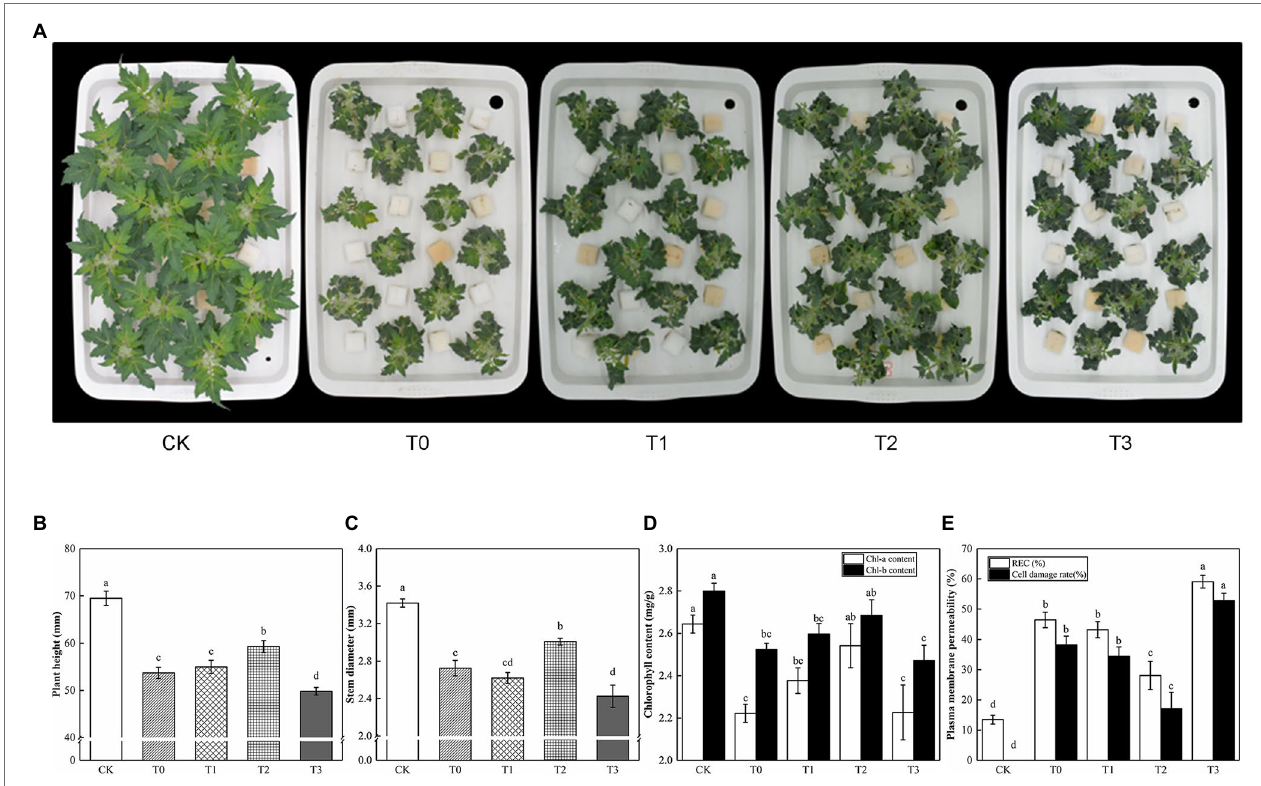
FIGURE 2 | Effect of different concentrations of trehalose on the growth and physiological parameter of tomato seedlings. Photographs and data were obtained after 5 days of treatment. (A) Morphological changes. (B) Plant height. (C) Stem diameter. (D) Chlorophyll content. (E) Plasma membrane permeability. The results showed the mean ± SE of three replicates, and the different letters denote the significant difference among treatments ( p < 0.05), according to Duncan’s multiple test. CK, control; T0, 150 mM NaCl; T1, 150 mM NaCl +5 mM trehalose; T2, 150 mM NaCl +10 mM trehalose; T3, 150 mM NaCl +25 mM trehalose.